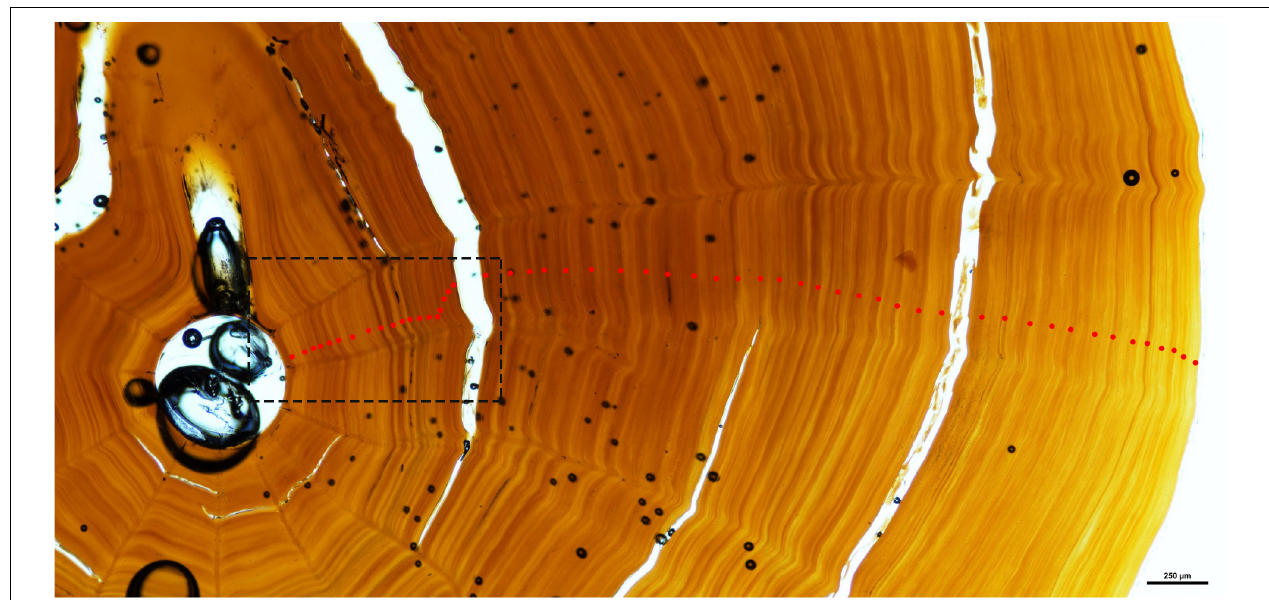
FIGURE 6 | Basal section of coral NIWA47911 showing the coarse coloured banding interpretation of the observed zone structure. The specimen shows 54 zones marked with red dots. Inset dashed rectangle shows the central portion of the basal section imaged in Figure 7 .